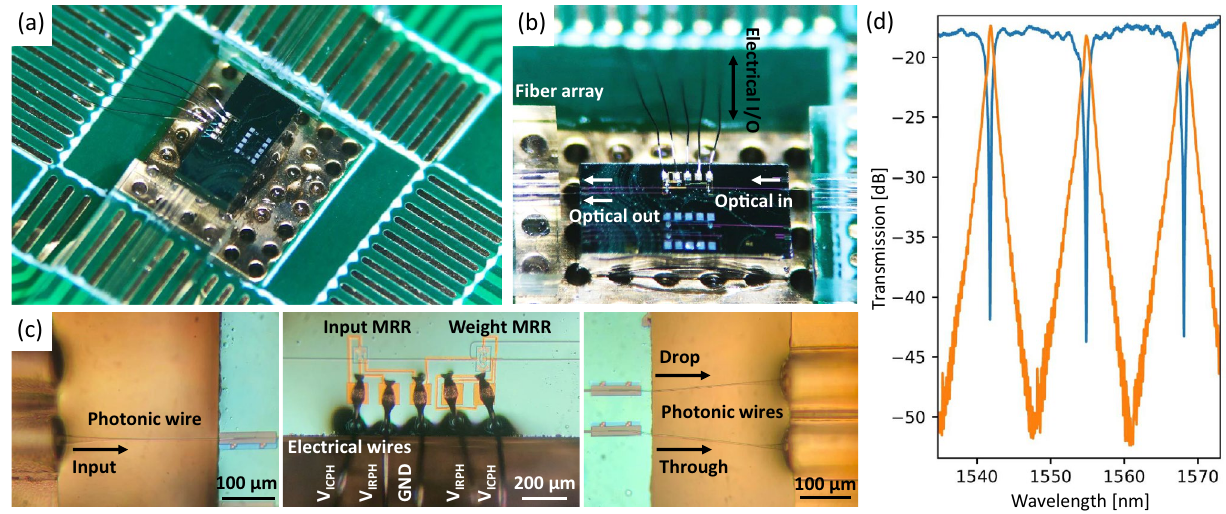
Figure 7. ( a ) Microscopic image of the co-packaged photonic chip on the PCB. ( b ) Zoomed-in image of the mounted photonic chip and V-grooves fiber arrays, showing the optical and electrical I/Os. ( c ) A series of zoomed-in images focusing on the photonic and electrical bonding wires and the photonic chip. ( d ) Measured as-fabricated transmission spectra of the photonic chip at through (blue) and drop (orange)